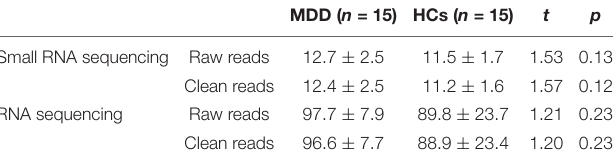
TABLE 2 | Summary of RNA sequencing